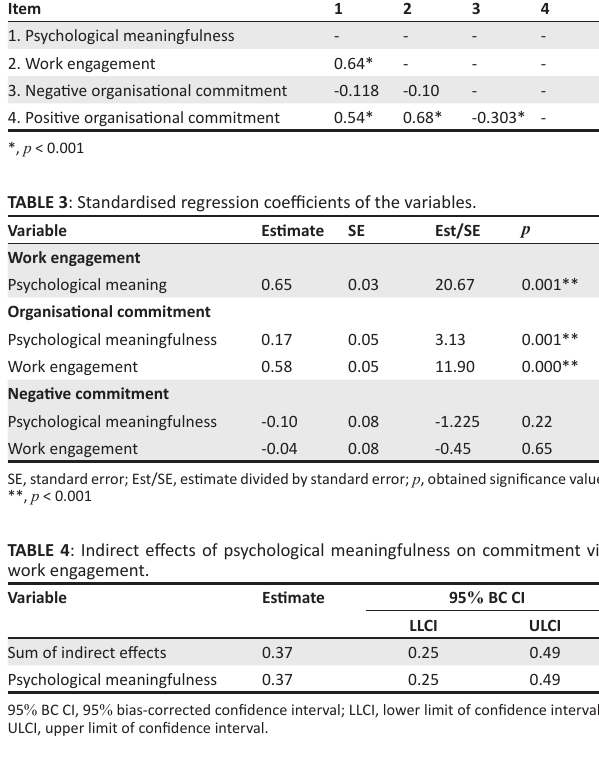
TABLE 1: Fit statistics of competing measurement models. Model